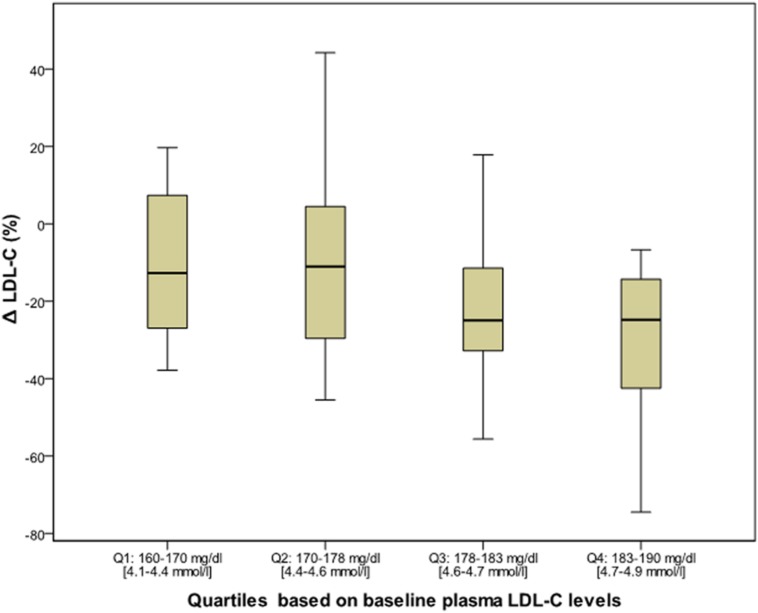
Box plots of Δ LDL-C (%) based on quartiles of baseline plasma LDL-C levels in all subjects (n = 80) after 6 months of Bergavit® (150 mg of flavonoids, with 16% of neoeriocitrin, 47% of neohesperidin, and 37% of naringin, daily) supplementation. LDL-C, low-density lipoprotein cholesterol.